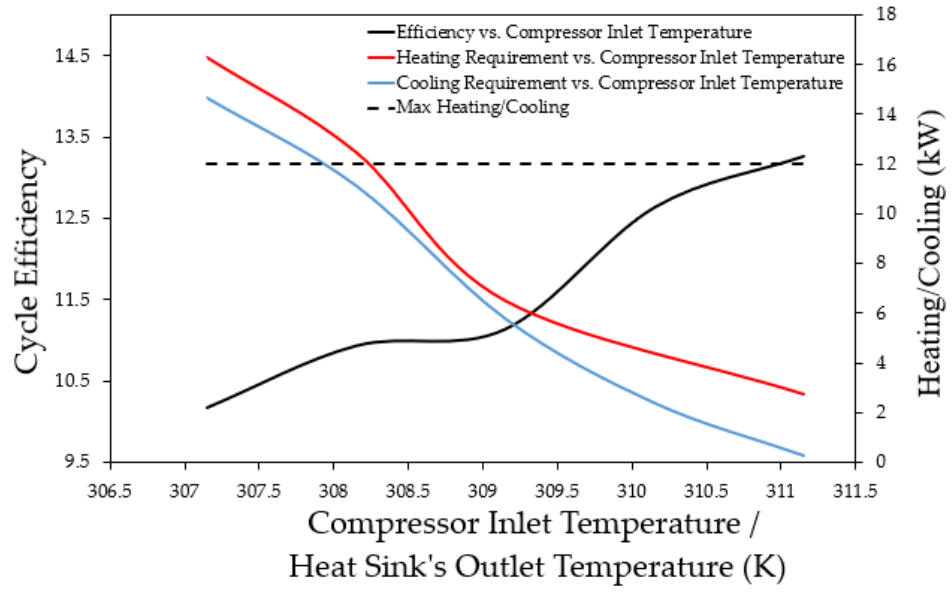
Figure 10. Cycle efficiency vs. compressor’s inlet temperature.